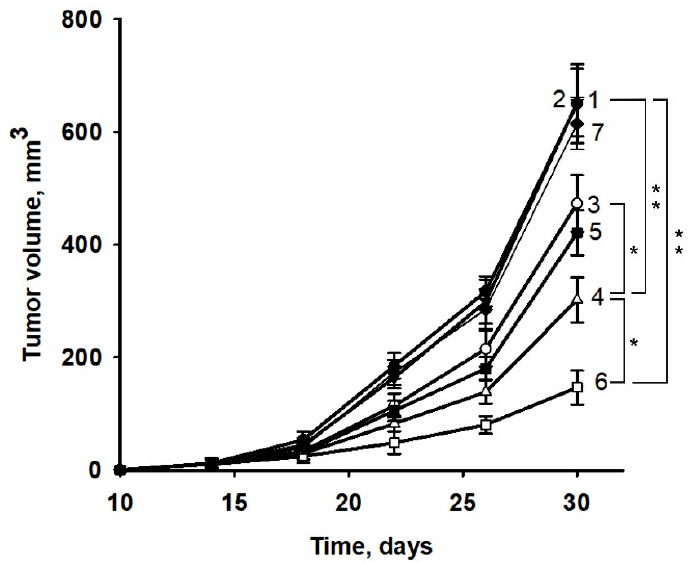
Figure 5. Tumor growth induced by an injection of HT-1080 human fibrosarcoma cells in control (1), treated according to the experimental protocol (see Materials and Methods section) by izTRAIL (2), sorafenib (3), izTRAIL and sorafenib (4), sorafenib and iRGD (5), izTRAIL and sorafenib and iRGD (6), izTRAIL and iRGD (7) * p < 0.05, ** p < 0,01.